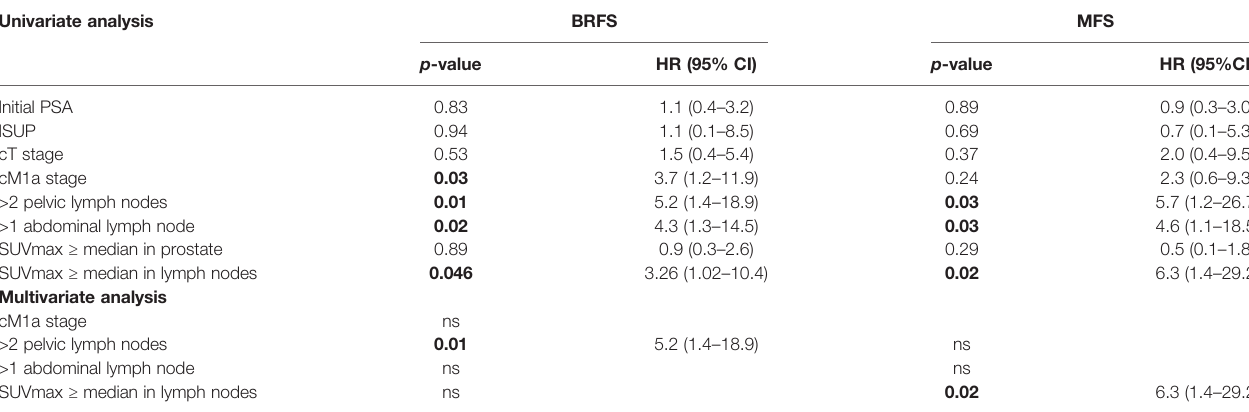
TABLE 2 | Univariate and multivariate Cox regression. p -values and hazard ratio (HR) with 95% con fi dence interval (CI) are shown for biochemical recurrence-free survival (BRFS) and metastasis-free survival (MFS). Univariate